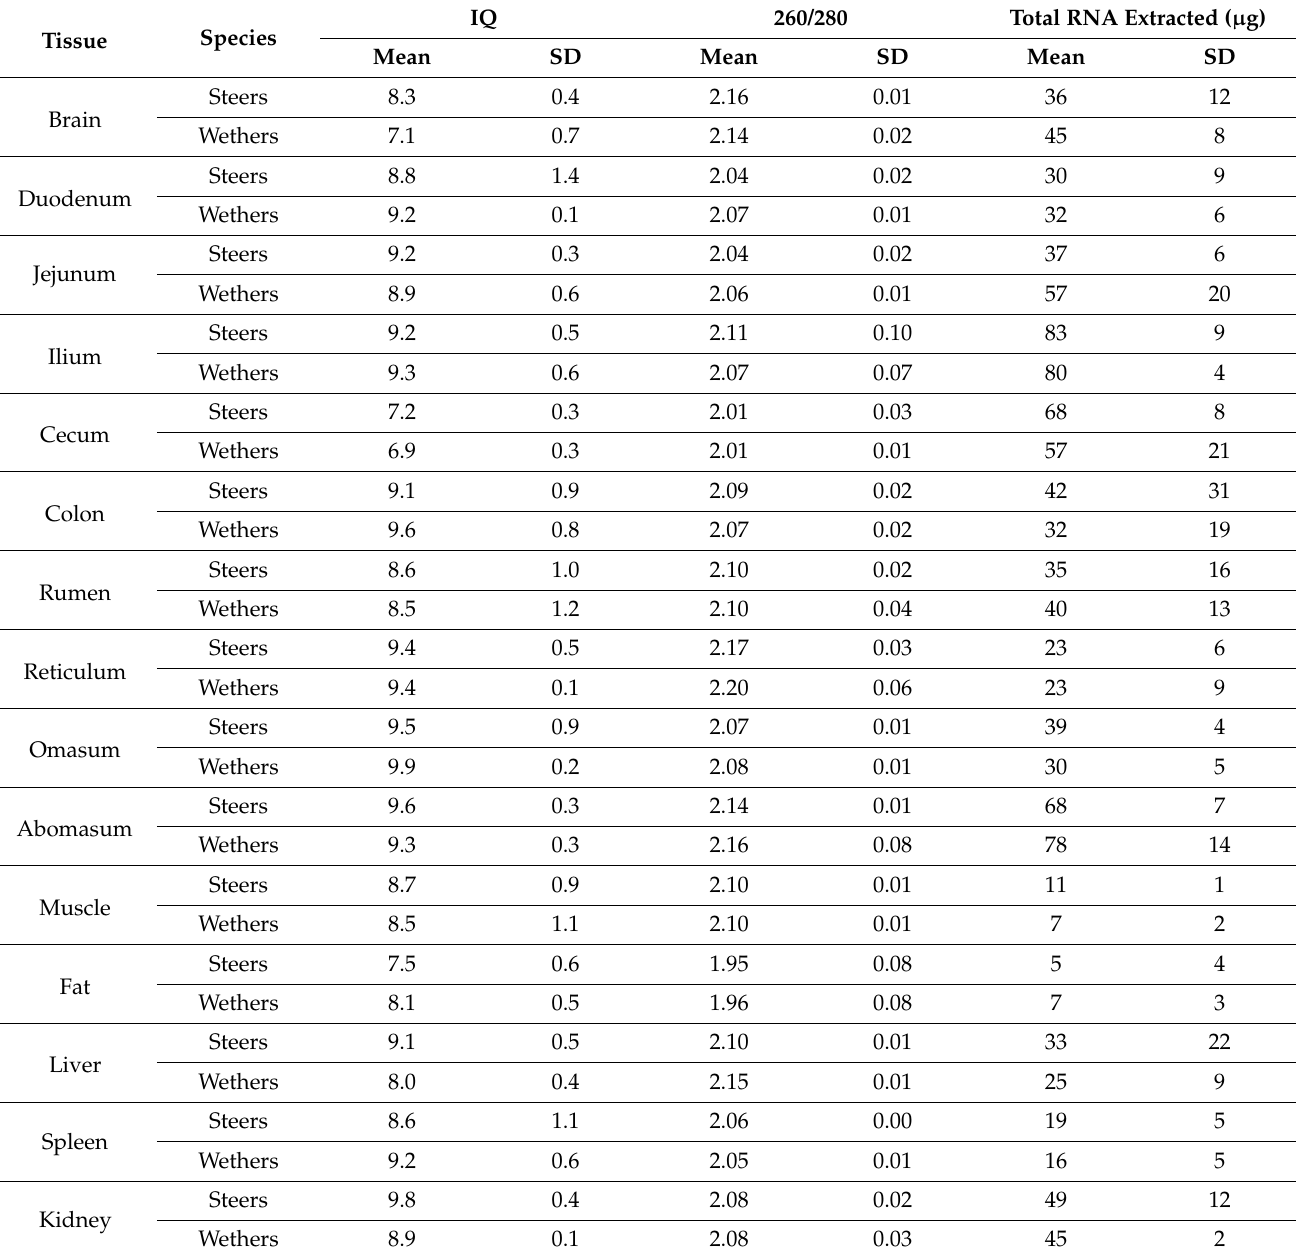
Table A2. Pooled sample specifics. The mean and standard deviation (SD) are reported for the RNA IQ, 260/280, and the total quantity of each cDNA